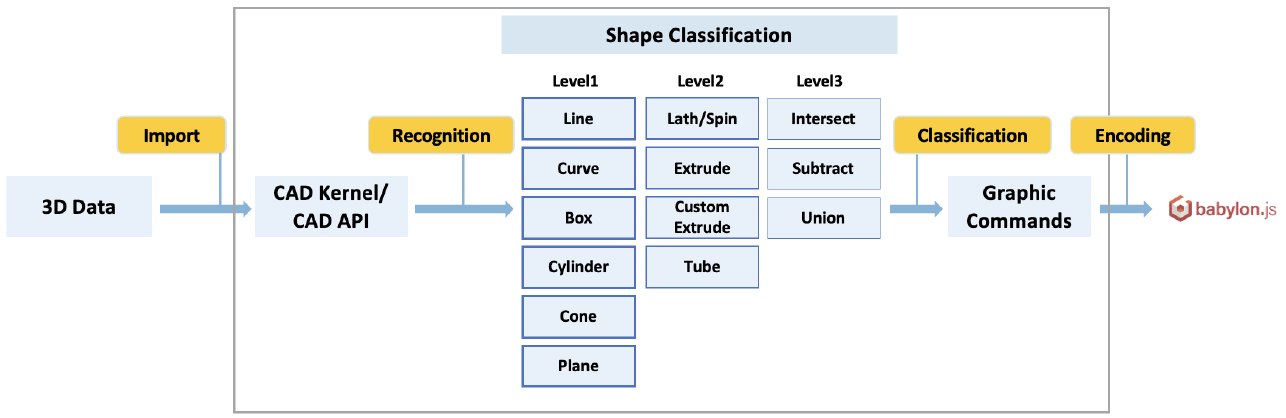
Figure 2. UML Class diagram of GIS DB.